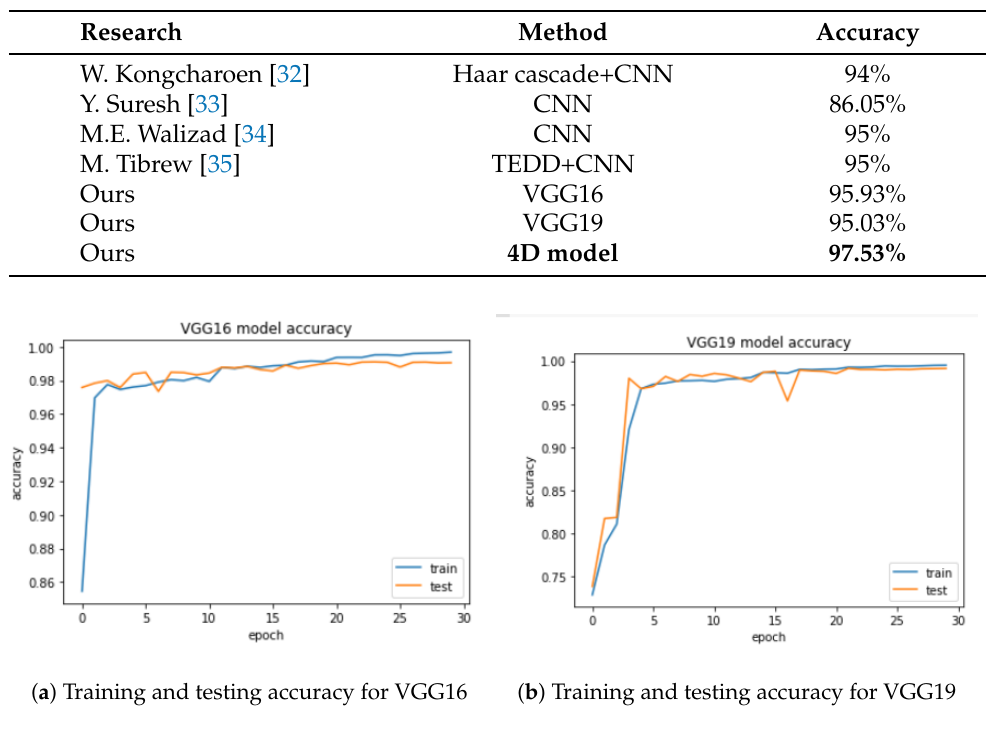
Table 4. Comparison of the proposed networks’ accuracy with that of various approaches when using the MRL Eye dataset.